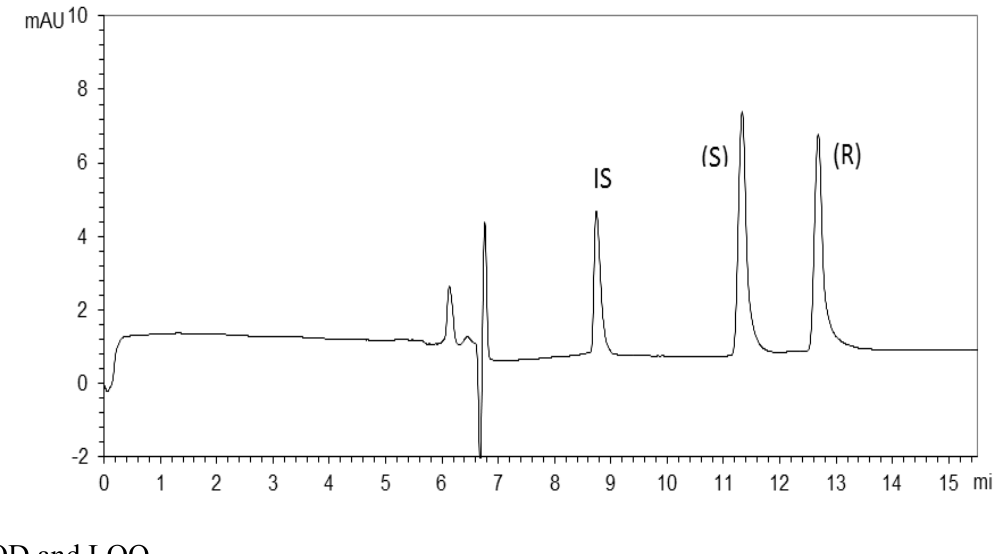
Figure 6. Electrophoretic separation of racemic modafinil at a concentration of 1.0 mg/mL. Separation condition: Benzamide (50 μ g/mL) used as internal standard; 20 mmol/L SBE - β -CD in 20 mmol/L phosphate buffer (pH 7.5) containing 20% methanol; 7 temperature, 25 °C; applied voltage, 20 kV; detection wavelength, 225 nm; injection, 50 mbar for 5 s; capillary, 50 cm × 50 μ m i.d. with effective length of 41.5 cm.